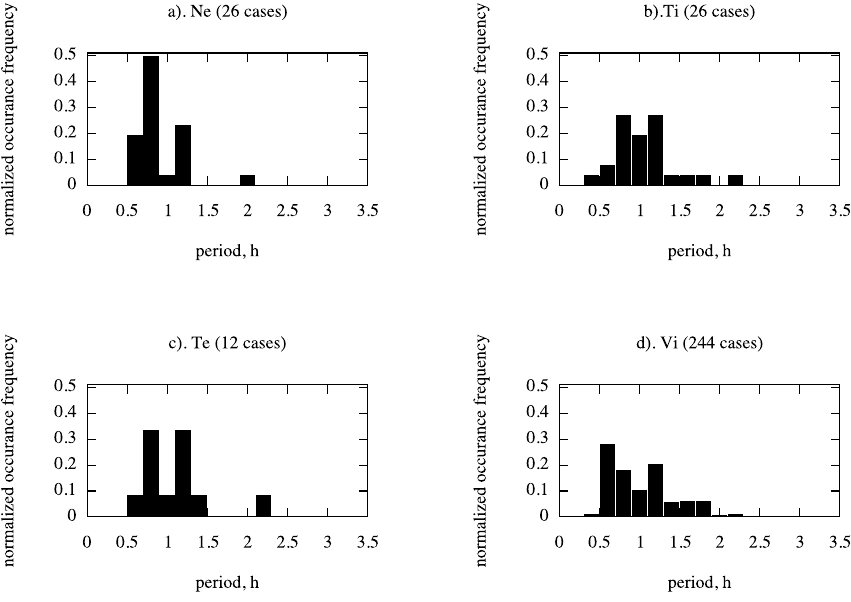
Fig. 9. Histogram of the oscillation period for (a) electron density, (b) ion temperature, (c) electron temperature, and (d) field-aligned ion velocity. For each parameter the occurrence rates have been normalized with the total number of AGW-TID cases observed in that parameter.